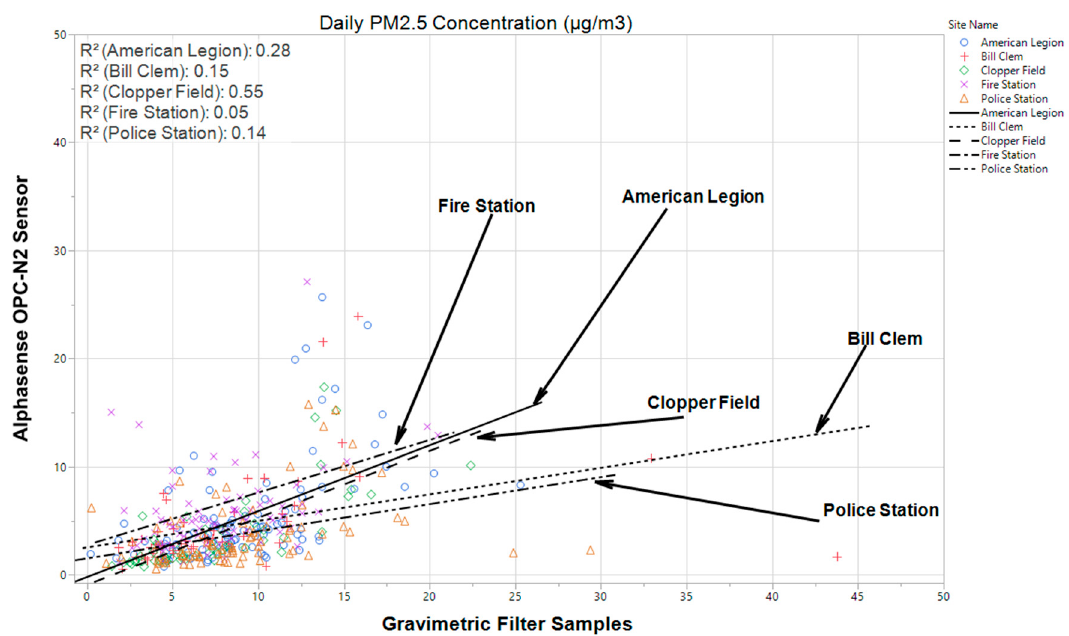
Figure 3. Comparison of PM 2.5 Concentrations from the OPC-N2 Sensor vs. Gravimetric Filter Samples (linear regression lines shown for each site) from 24 October 2017 through 31 October 2018. OPC-N2 sensor PM 2.5 concentrations are 24-h averages. The gravimetric filter sample concentrations are 24-h integrated values.